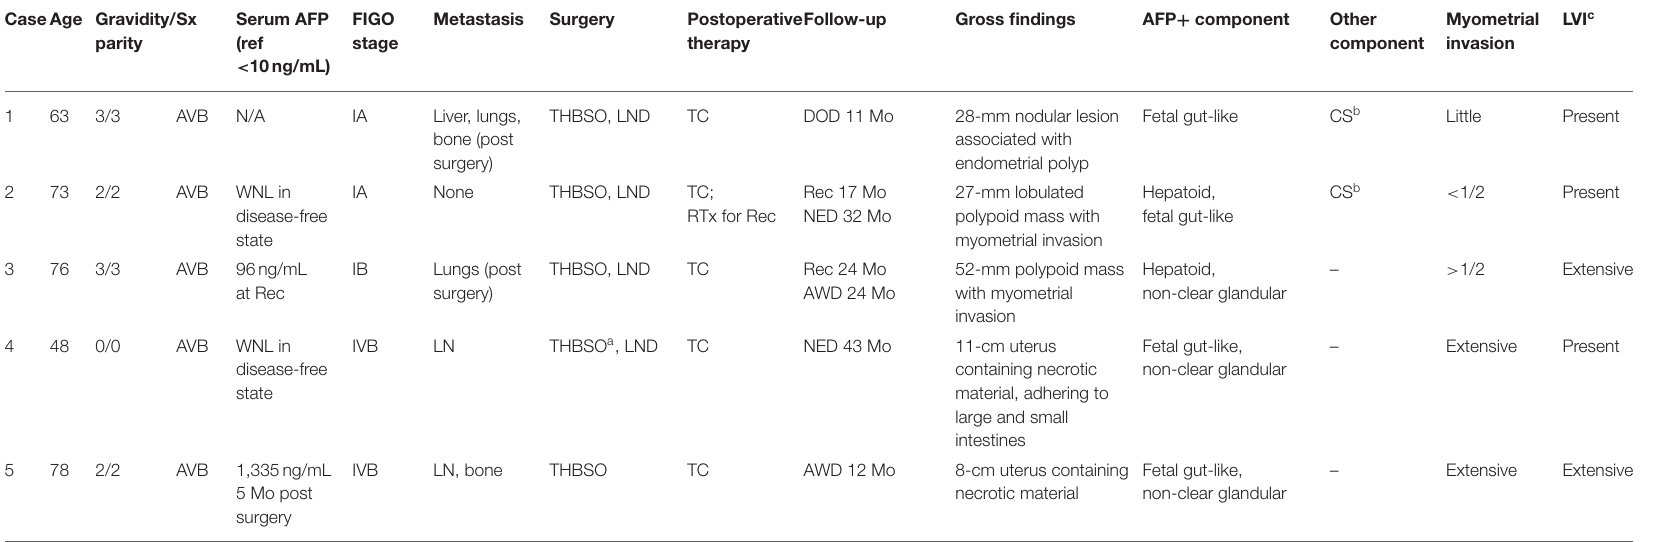
AFP, α -fetoprotein; AVB, abnormal vaginal bleeding; AWD, alive with disease; CS, carcinosarcoma; FIGO, International Federation of Gynecology and Obstetrics; LN, lymph nodes; LND, pelvic and para-aortic lymphadenectomy; LVI, lymphovascular invasion; Mo, months; N/A, not available; NED, no evidence of disease; Rec, recurrence; RTx, radiation therapy; SO, salpingo-oophorectomy; Sx, presenting symptom; TC, paclitaxel and carboplatin; THBSO, total hysterectomy and bilateral salpingo-oophorectomy; WNL, within normal limits. a Sections of large and small intestines attached to the uterus were also resected. b Associated with endometrial polyp. c Investigated with D2-40 and CD31